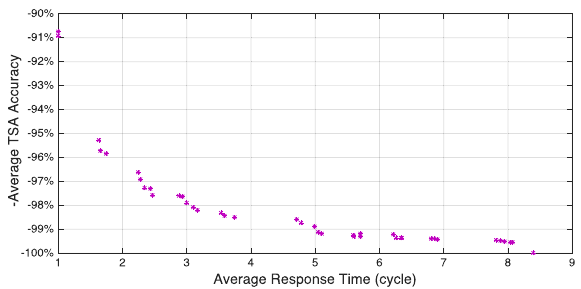
Fig. 6 The POF obtained in Performance